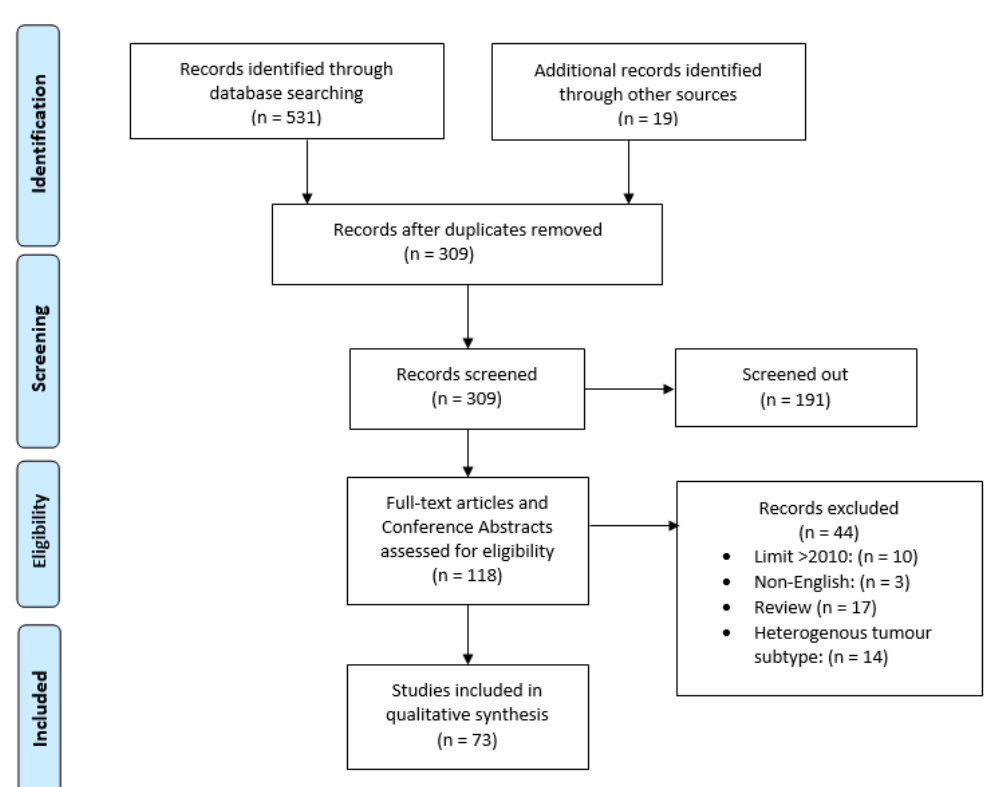
Figure A1. PRISMA flow diagram.